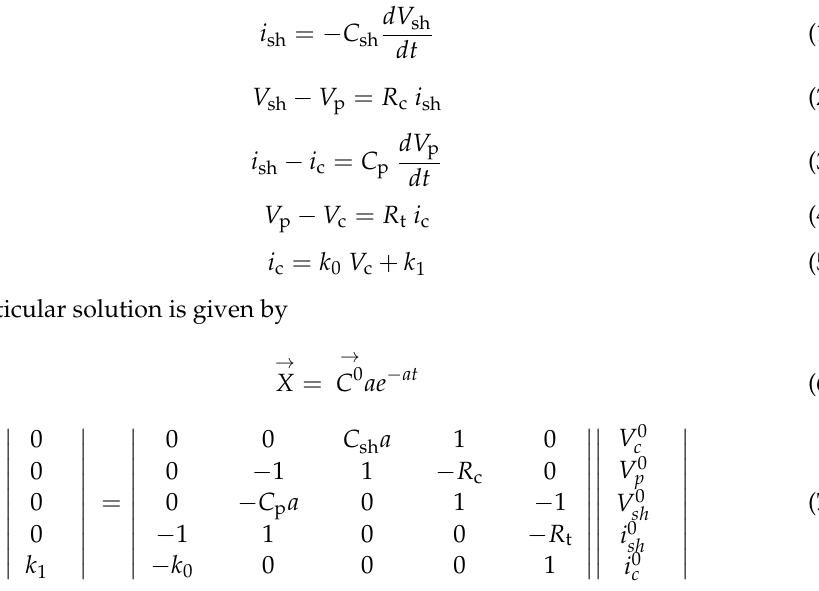
Figure 6. Electrical transmission line equivalent circuit diagram for modeling heat conduction properties; the physical variables are specified in their thermal equivalents.